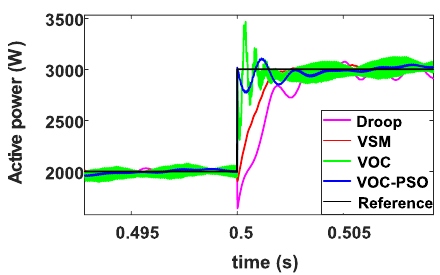
Fig. 17 The active power’s dynamic behavior to a change in load (the quick load change is represented in the black color line)